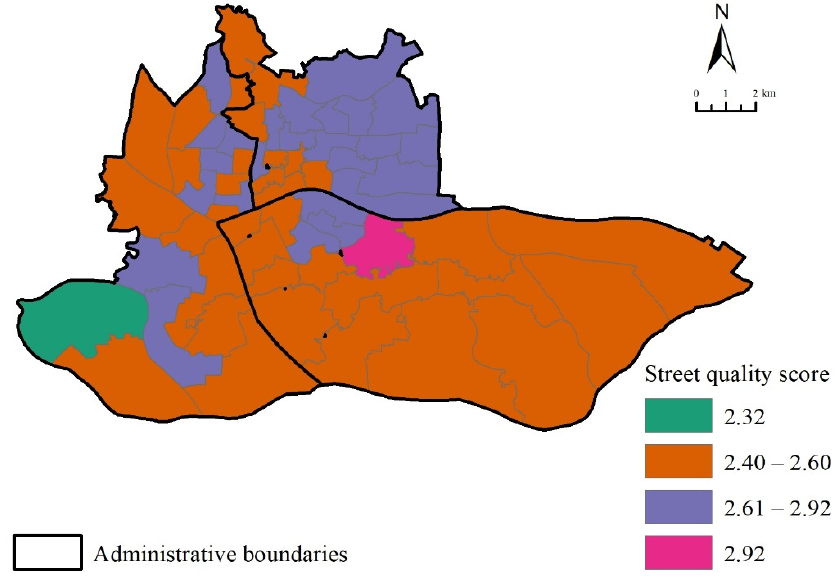
Figure 9. Spatial Distribution of Street Element Quality Scores.